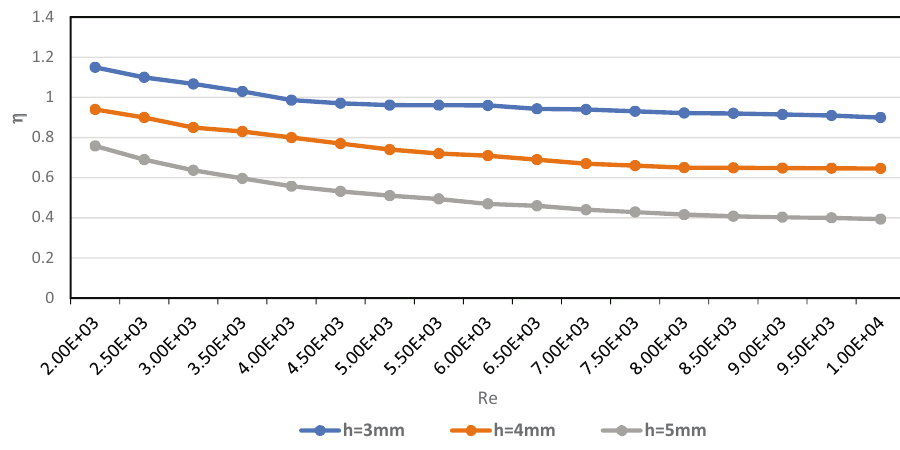
Figure 8: The e ff ect of ba ffl e height on heat transfer